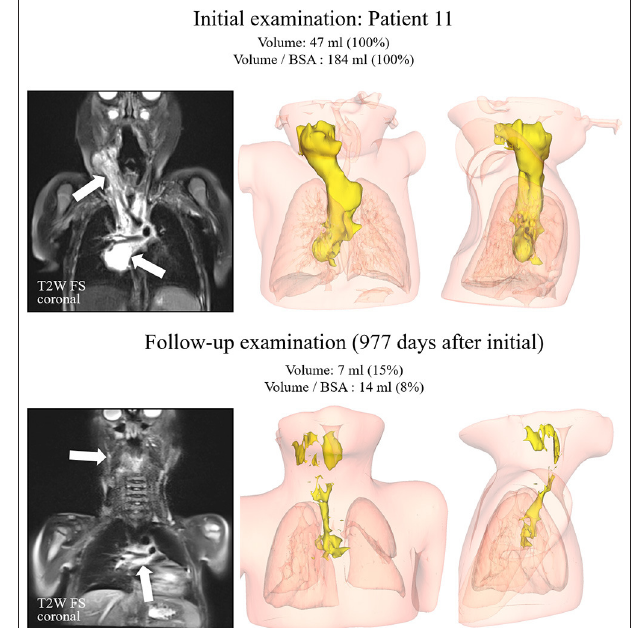
FIGURE 2 | Patient #11. T2-weighted images with fat saturation in the coronal plane on the left side for both examinations. The kaposiform hemangioendothelioma demonstrated a high signal intensity (arrows) on both examinations, with substantial volume reduction over time. Corresponding 3D reconstructions in anteroposterior and mediolateral views are displayed in the middle and right